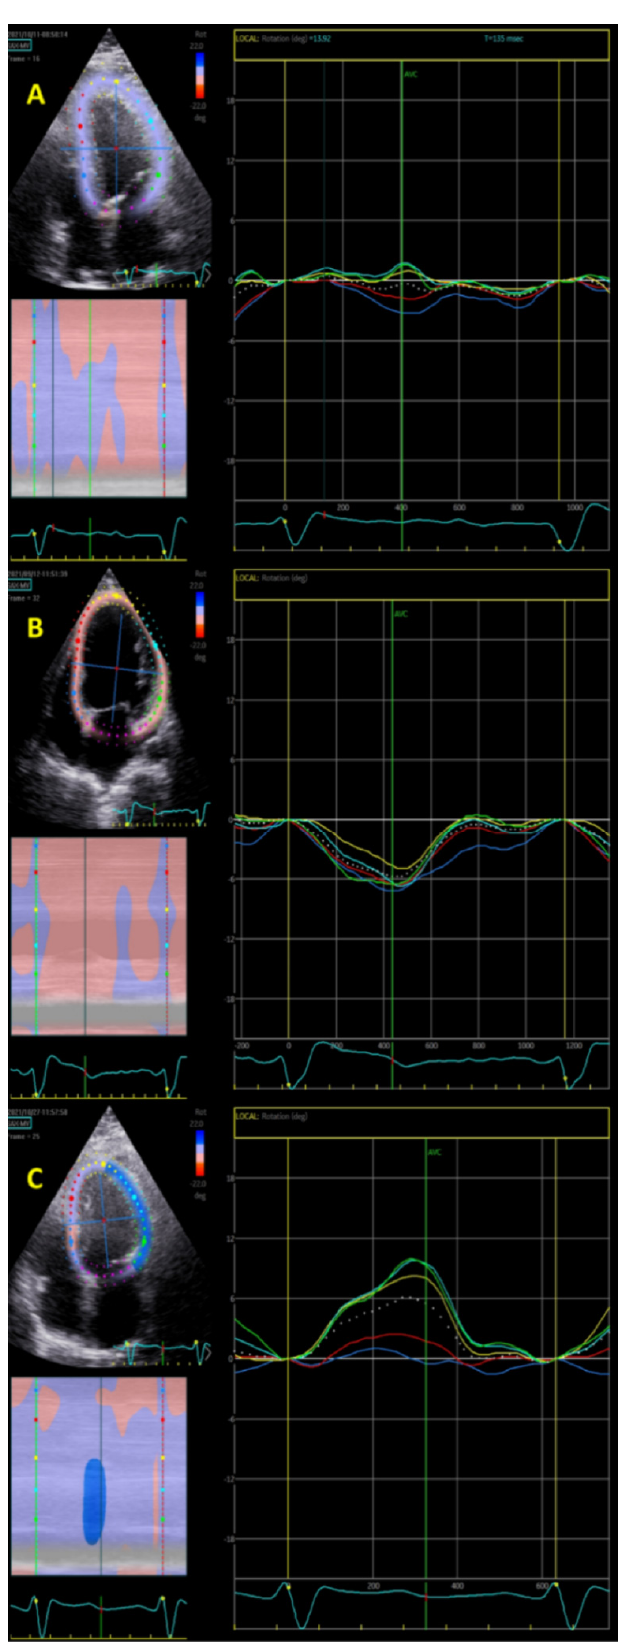
Figure 1. Examples of longitudinal rotation direction and extent in the various patterns analyzed using circumferential rotation algorithm on longitudinal images. Note the “posterior” or